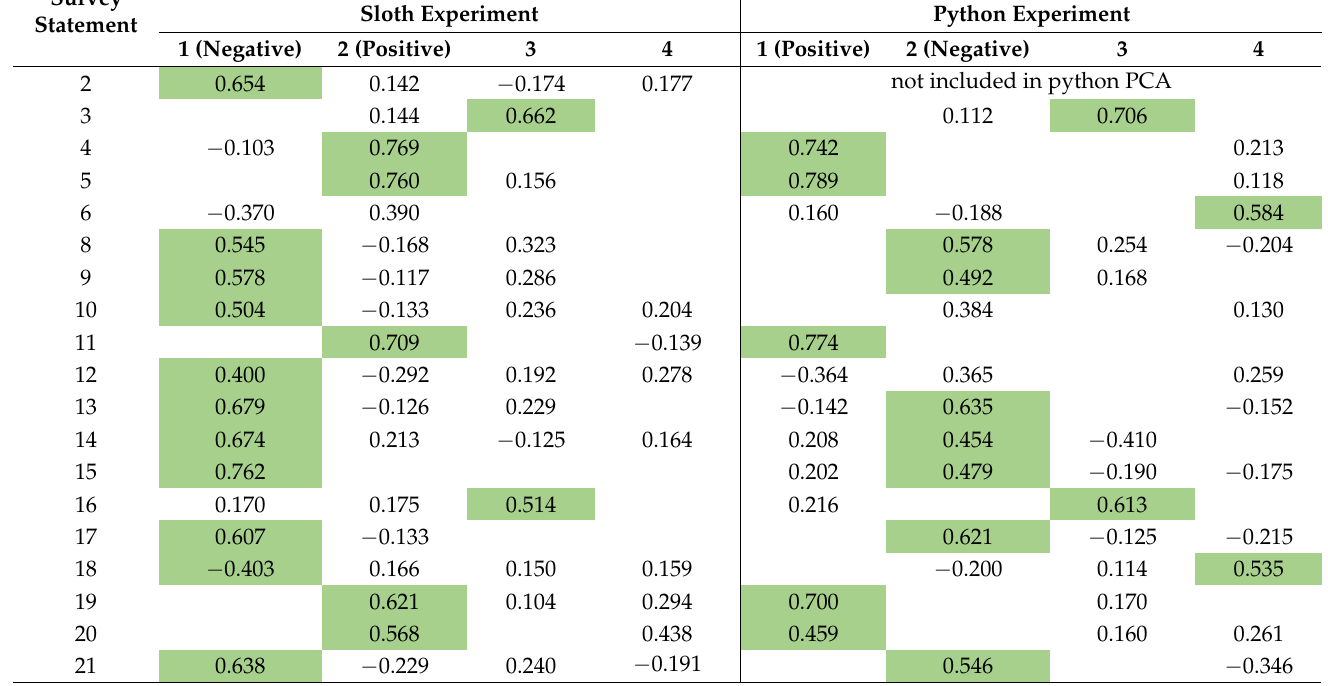
Table 2. Principal component analyses (PCA) for the sloth and python experiments. The highest loadings for each component that were ≥ |0.4| are shown in green. We conceptually labeled the first two components into attitude types. The third component emulated a protectionist attitude. Survey statement 1 was the subject of another study [26] and is not included below but can be found in Supplementary